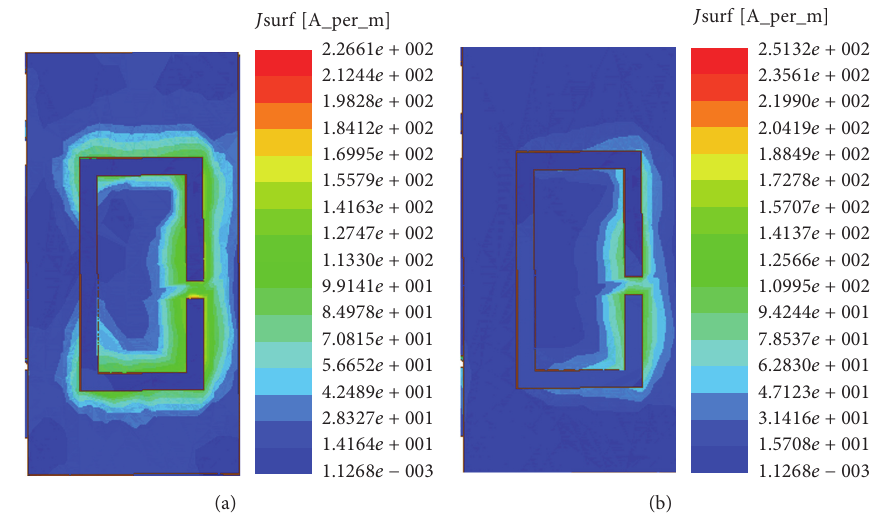
Figure 7: Surface current distribution on the top plate at (a) 8 GHz and (b)